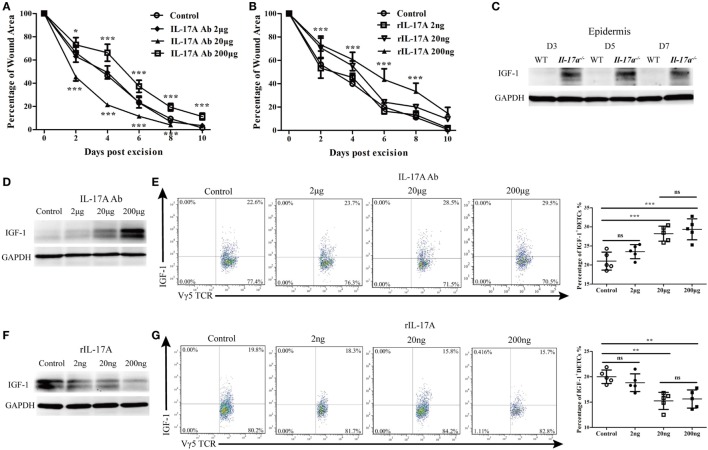
IL-17A inhibited the production of IGF-1 in epidermis around wound after skin injury. (A) Addition of various doses of IL-17A neutralizing Ab (0, 2, 20, and 200 μg/wound) into wound margin of WT mice on days 0, 1, and 2 after skin injury. Wound-closure kinetics was measured over time and dots in wound closure kinetics represent 10 wounds per group (2 wounds/mouse, 5 mice/group). Upper stars stand for the comparations between IL-17A Ab 200 μg and Control, and lower stars represent the comparations between IL-17A Ab 20 μg and Control. (B) Wound closure kinetics in WT mice treated with various doses of rIL-17A (0, 2, 20, and 200 ng/wound) on days 0, 1, and 2 after skin injury (n = 10 wounds/group). Stars stand for the comparations between rIL-17A 200 ng and Control. (C) The production of IGF-1 in epidermis around wound of WT and IL-17a−/− mice on days 3, 5, and 7 post-excision was examined by WB. (D,E) Addition of various doses of IL-17A neutralizing Ab (0, 2, 20 and 200 μg/wound) into wound margin of WT mice on days 0, 1, and 2 after skin injury. Epidermis around wound was collected on day 3 post-excision. IGF-1 expression was determined by WB (D) and FACS (E). (F,G) Addition of various doses of rIL-17A (0, 2, 20, and 200 ng/wound) into wound margin of WT mice on days 0, 1, and 2 after skin injury. Epidermis around wound was collected on day 3 post-excision. The production of IGF-1 was detected by WB (F) and FACS (G). Epidermal sheets around wounds were collected from 3–7 mice with 4 wounds/mice in (C–G). Data are representative of three individual experiments. Bars are shown mean ± SD. P value was determined by one-way ANOVA with Student’s unpaired t-test (A,B) or Bonferroni’s comparision test (E,G) (*P < 0.05, **P < 0.01, ***P < 0.001).